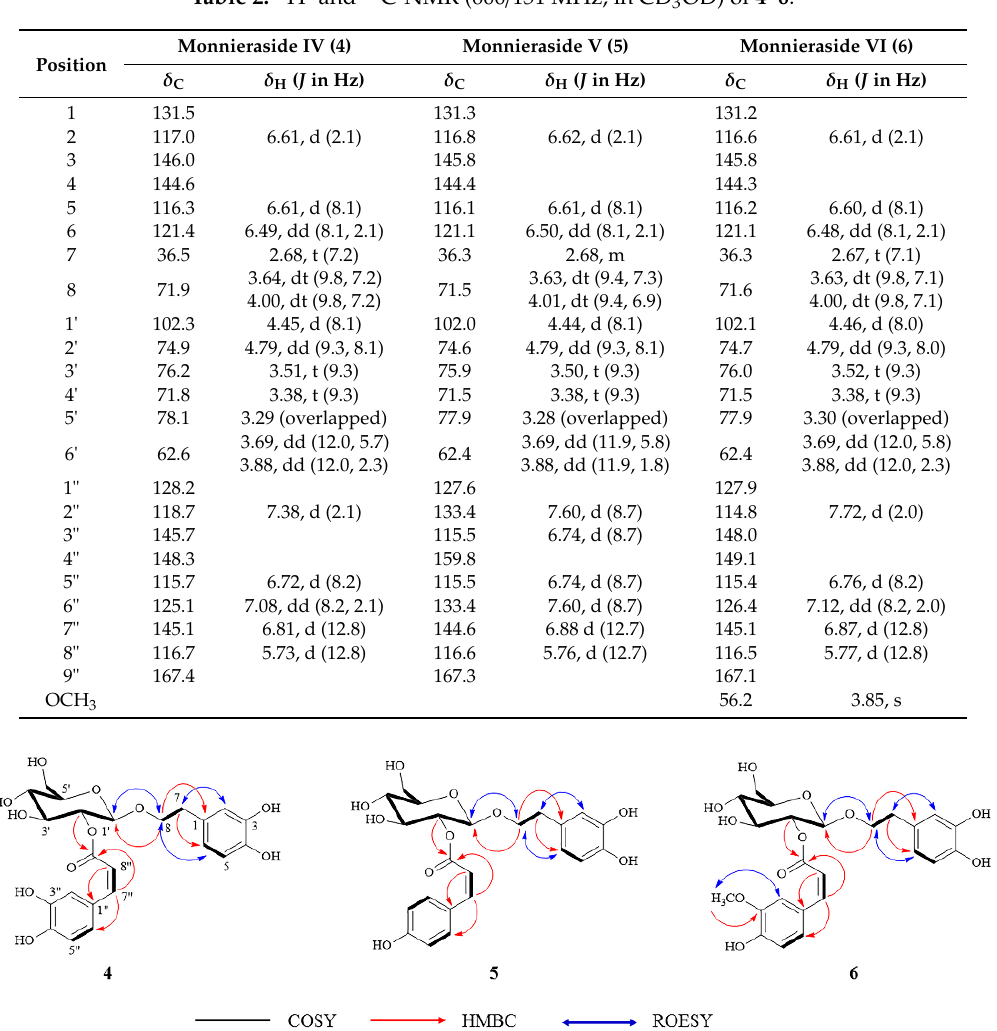
Figure 5. The COSY, HMBC and ROESY correlations of new compounds 4 ‒ 6